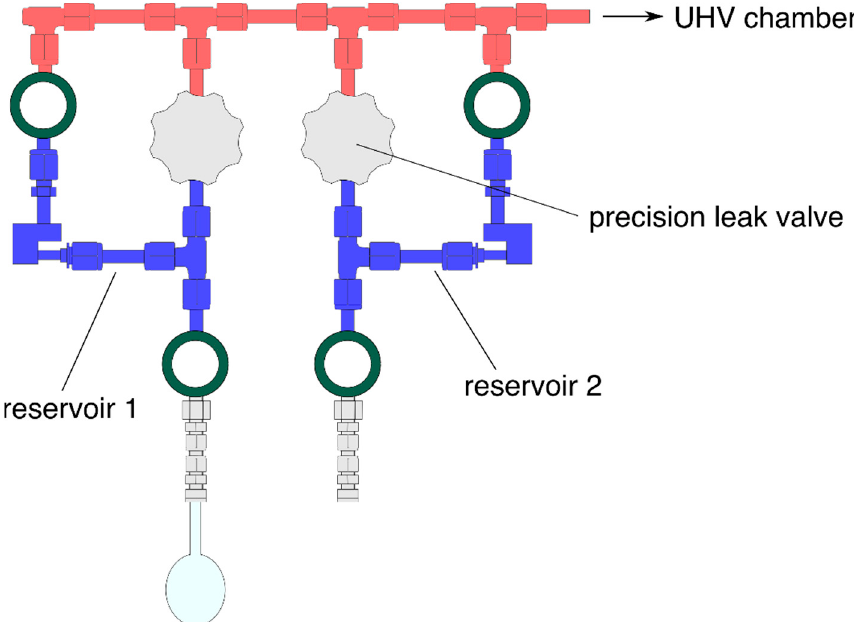
Figure 3. Schematic representation of the gas handling manifold with storage reservoirs (shaded in blue) and the mixing reservoir (shaded in red).